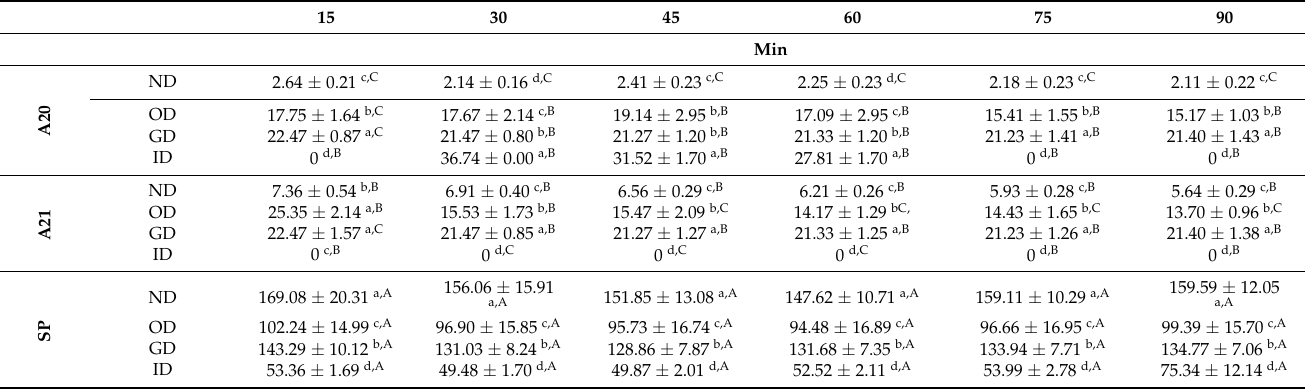
Table 3. Effect of in vitro digestion on 2,2-diphenyl-1-picrylhydrazyl (DPPH • ) inhibition of the three phenolic extracts, calculated as IC 50